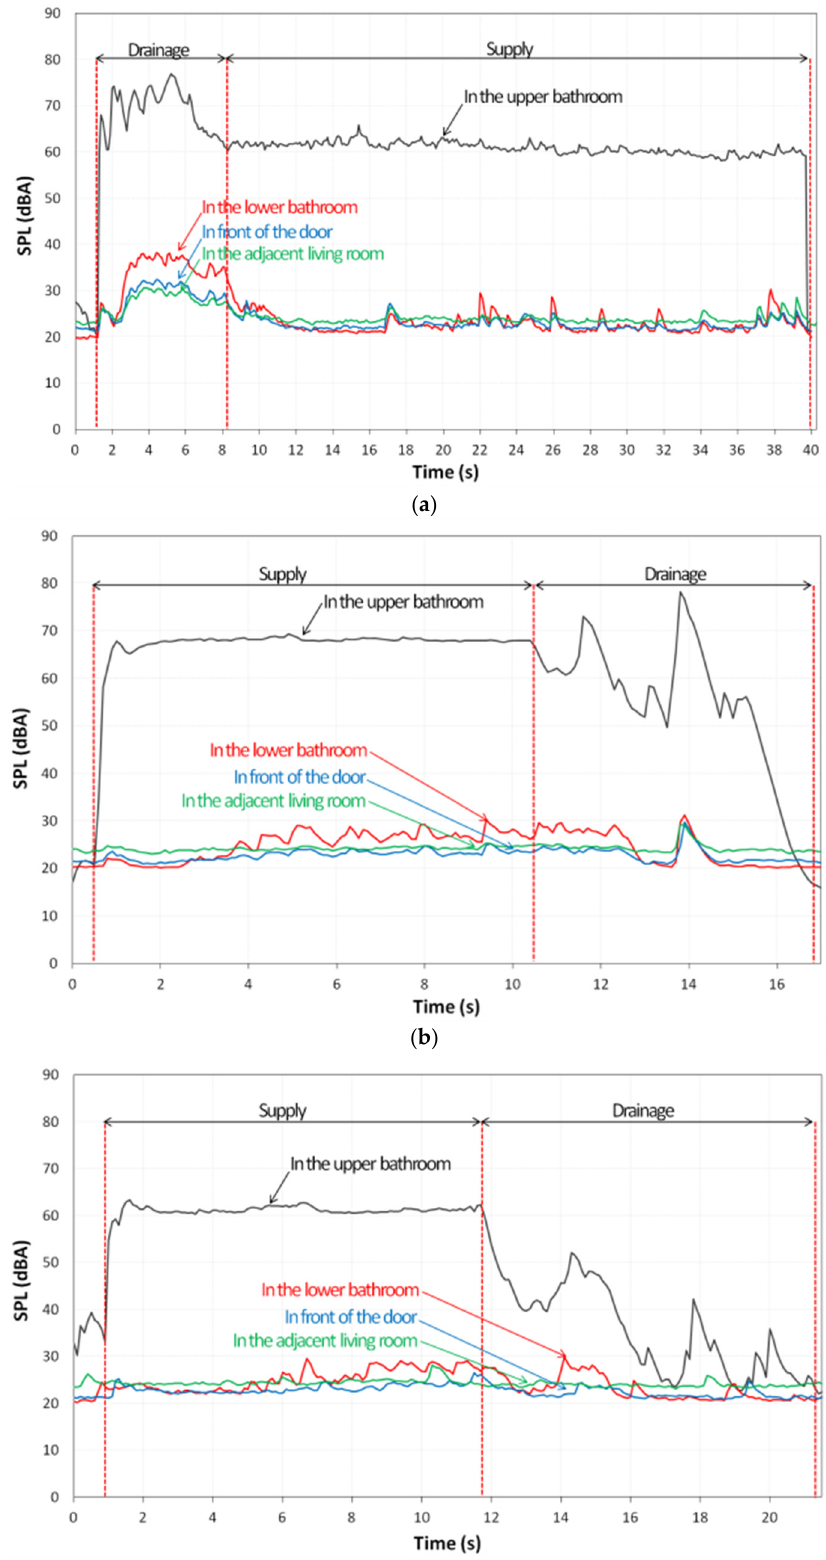
Figure 5. Time history of water supply and drainage noises from the use of sanitary wares including the ( a ) water closet, ( b ) basin, and ( c ) bathtub measured at different locations (only a part of the time history has been shown due to long ‐ time operation).